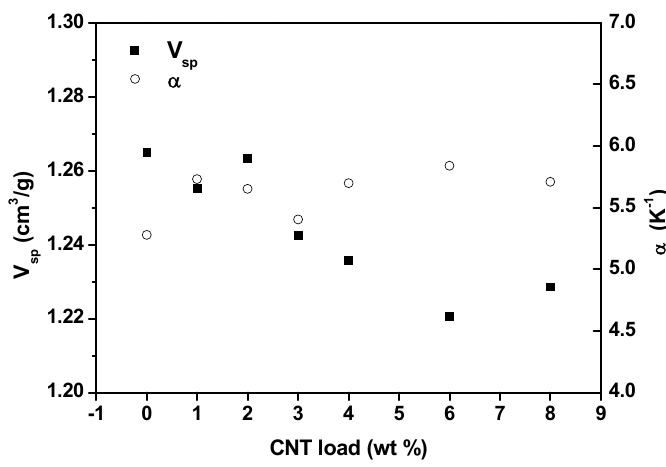
Figure 6. Specific volume (filled symbols) and thermal expansion coefficient (empty symbols) results at T = 180 °C and P = 200 bar for PP and MWCNT/PP nanocomposites of indicated MWCNT